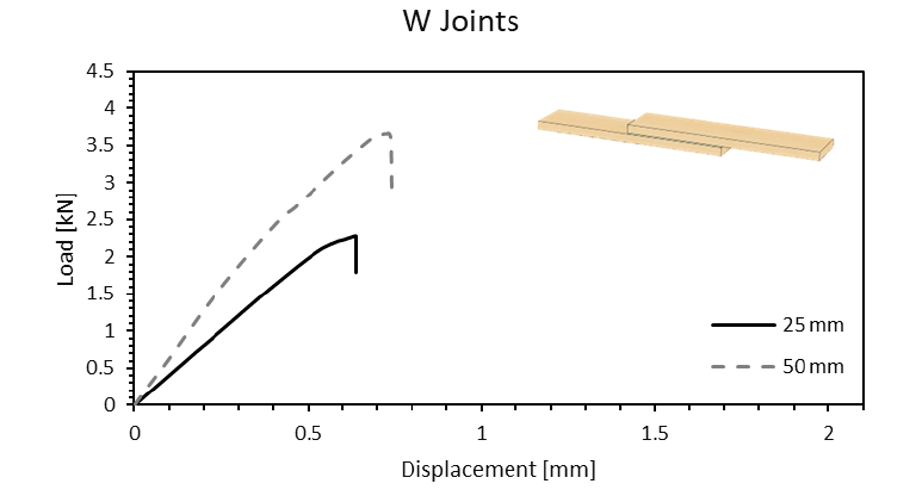
Figure 9. Load-displacement curve of a W joint for 25- and 50-mm overlap